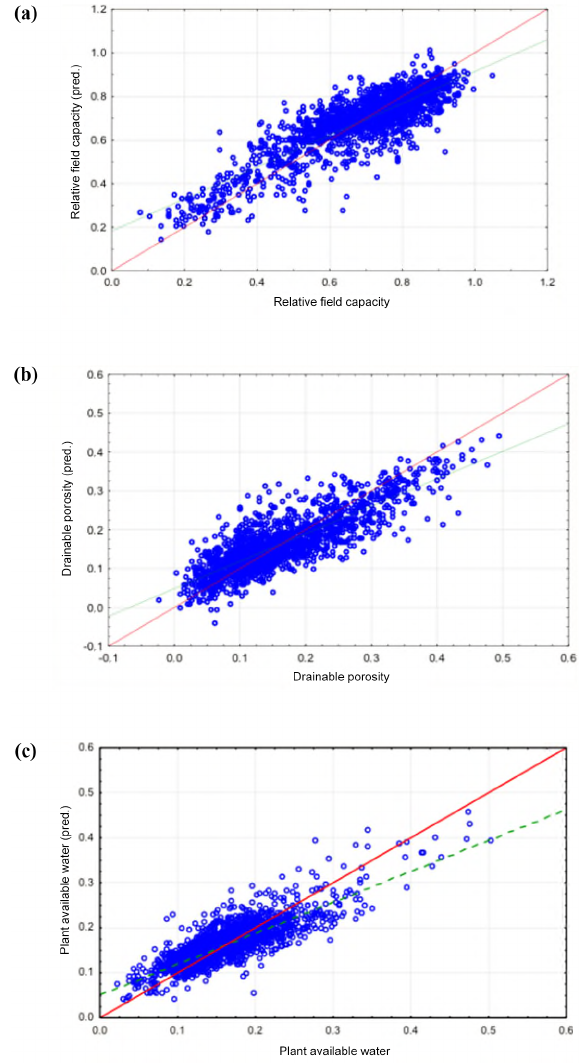
Figure 4. Biplots representing the predicted SQI versus observed SQI based on the MARS pedotransfer functions. (a) Relative field capacity. (b) Drainable porosity. (c) Plant available